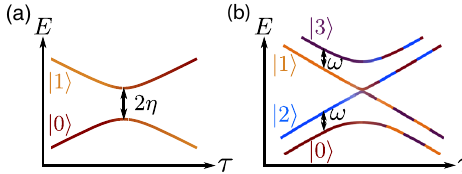
FIG. 6. (a) Adiabatic energy levels of the Landau-Zener- Stückelberg-Majorana model as a function of time. A purely adiabatic evolution realizes an effective NOT gate on the qubit levels j 0 i , j 1 i . Colors indicate how the adiabatic eigenstates evolve in the j 0 i , j 1 i basis. (b) A similar plot of adiabatic energy levels versus time for the multiple-crossings Landau-Zener model, where in addition to the qubit levels, there are two additional leakage levels j 2 i , j 3 i . Colors again indicate how the adiabatic eigenstate wave functions evolve in the j 0 i , j 1 i , j 2 i , j 3 i basis. Because of mixing with the leakage levels, a pure adiabatic evolution no longer results in a NOT gate of the qubit states. Here, we sketch the situation where ω 2 ¼ ω 3 ¼ ω , the spurious couplings are comparable to η , and ω ≲ η